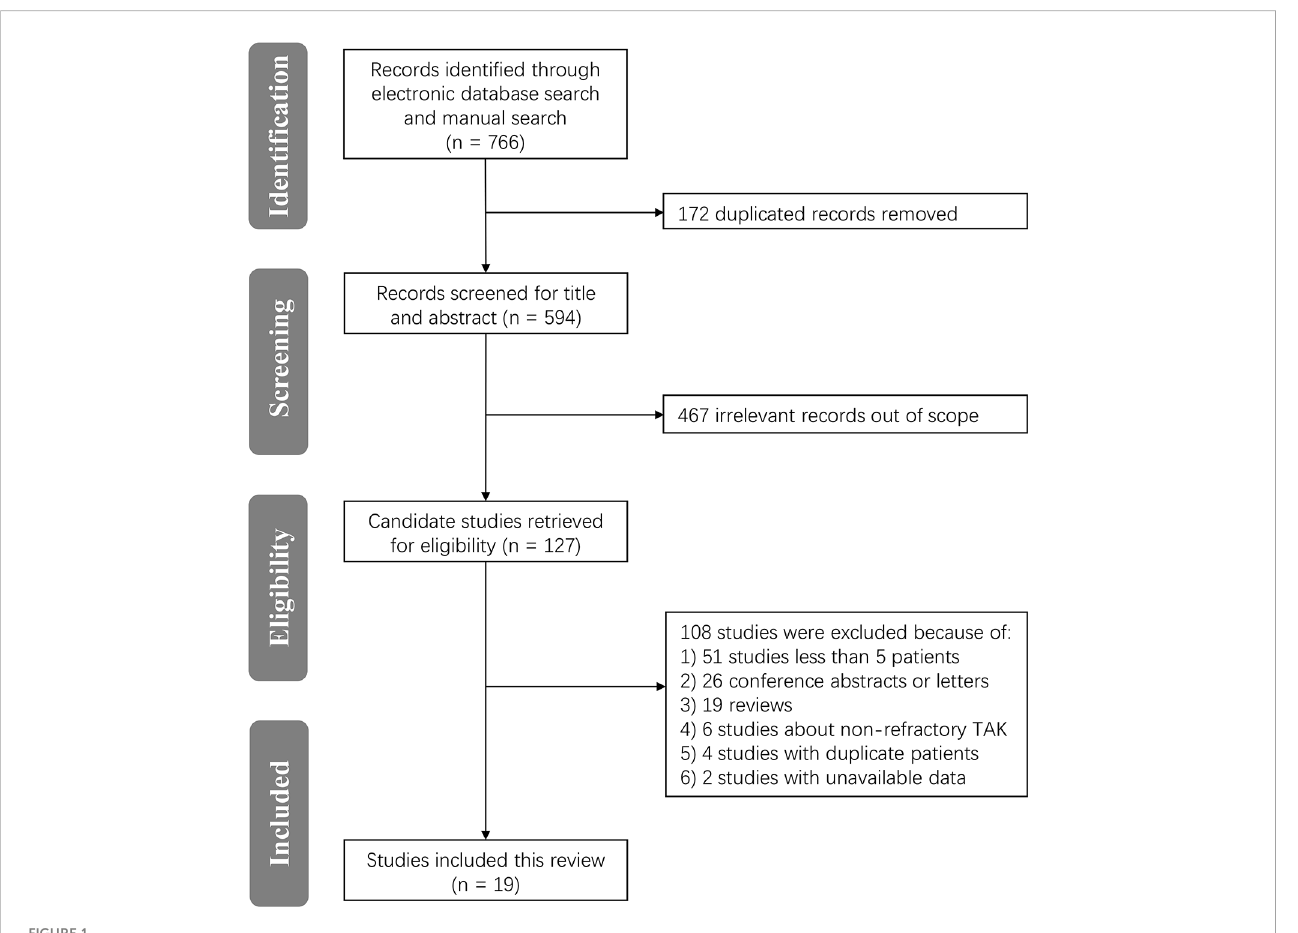
FIGURE 1 PRISMA fl ow chart of the literature search and selection of included